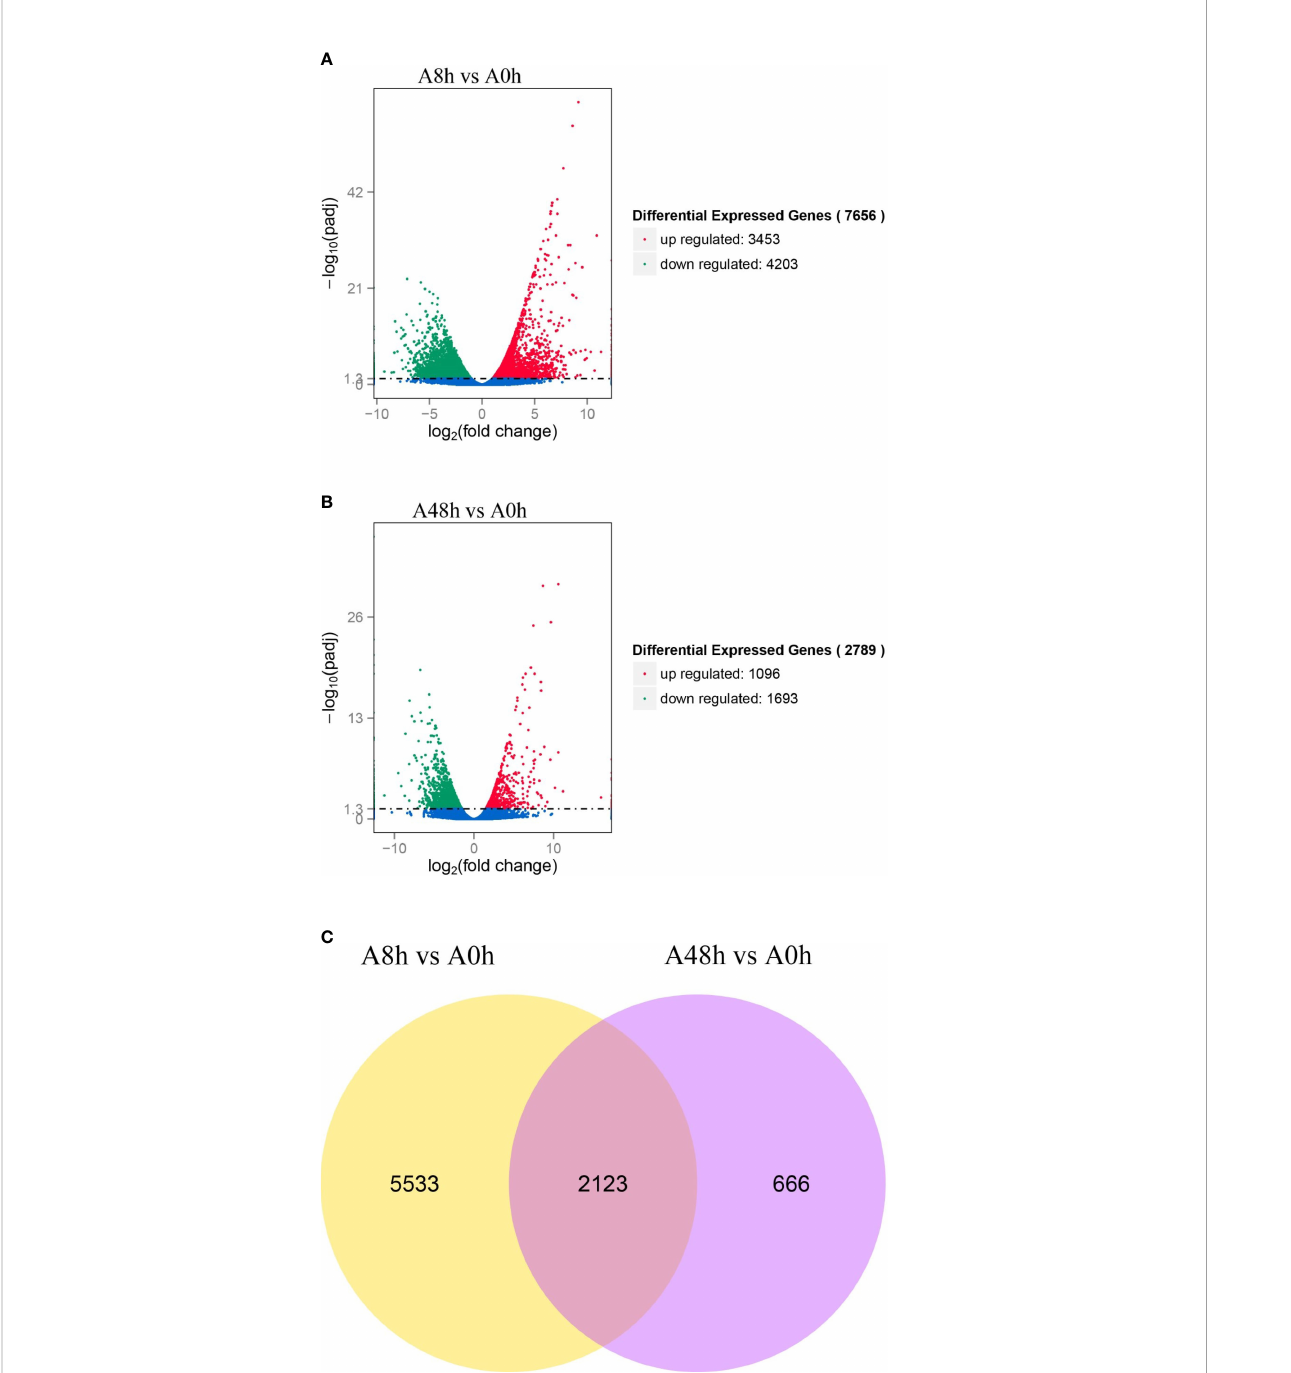
FIGURE 1 (A) Volcano plot of differentially expressed genes (DEGs) distribution trends between A8h vs. A0h sample. (B) Volcano plot of DEGs distribution trends between A48h vs. A0h sample. Each dot in the volcano plot represents a detected gene. Genes with signi fi cant differential expression are denoted by red dots (upregulated) and green dots (downregulated). Genes without signi fi cant differential expression are indicated by blue dots. Horizontal ordinate signi fi es the fold change of DEGs, whereas vertical ordinate stands for statistical signi fi cance of DEGs between A8h vs. A0h and A48h vs. A0h groups. (C) Venn diagrams of DEGs. There are 7,656 and 2,789 DEGs between A8h vs. A0h and A48h vs. A0h, respectively. Among all DEGs, a total of 2,123 differential genes were overlapped expressed both in A48h and A8h groups compared with unchallenged